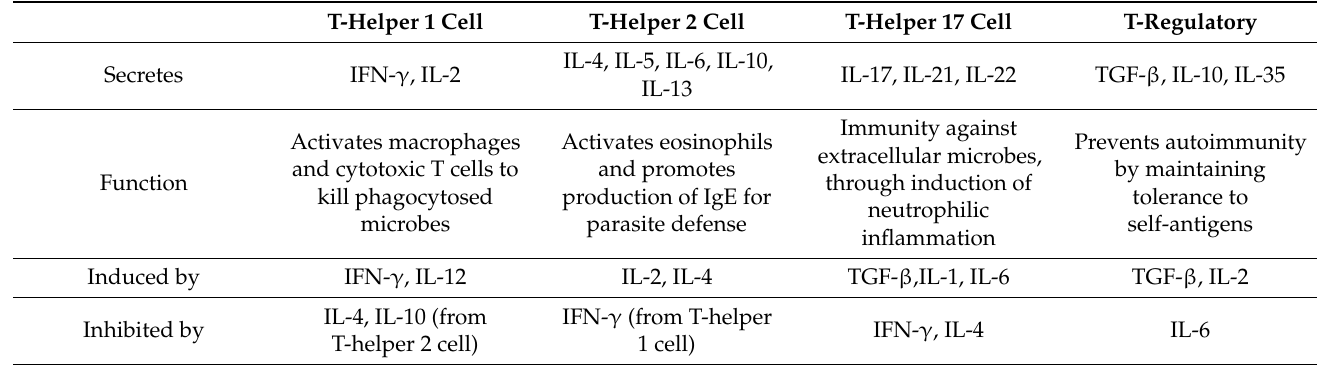
Table 1. Function of T-Helper